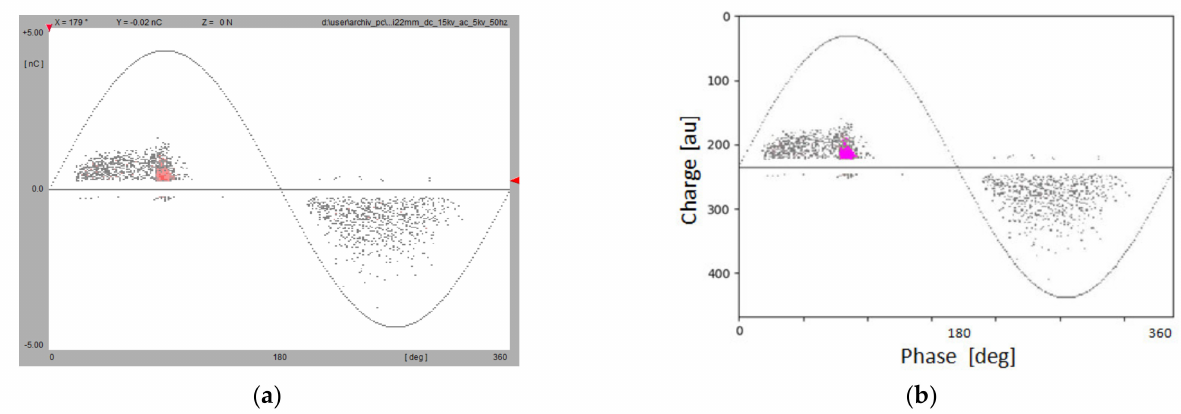
Figure 8. Extraction of PD inception component from PD image: ( a ) related to AC harmonic. inception; ( b ) present in HVDC configuration with dominant DC voltage (pink).